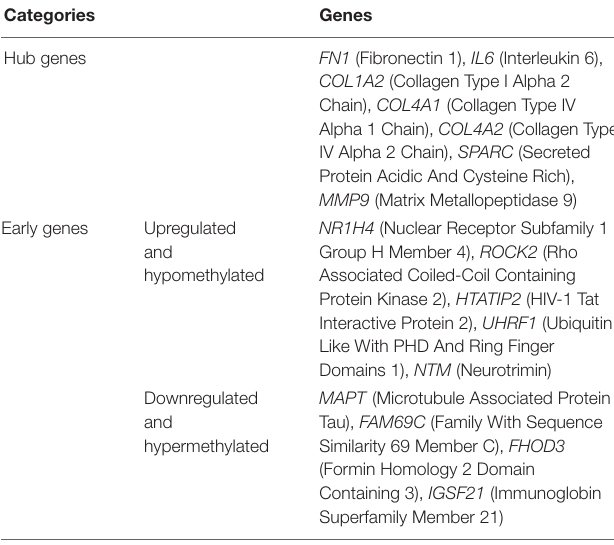
Hub genes: potential candidate genes of DR which possess large number of interaction. Early genes: genes showing altered expression and methylation pattern during an early stage of